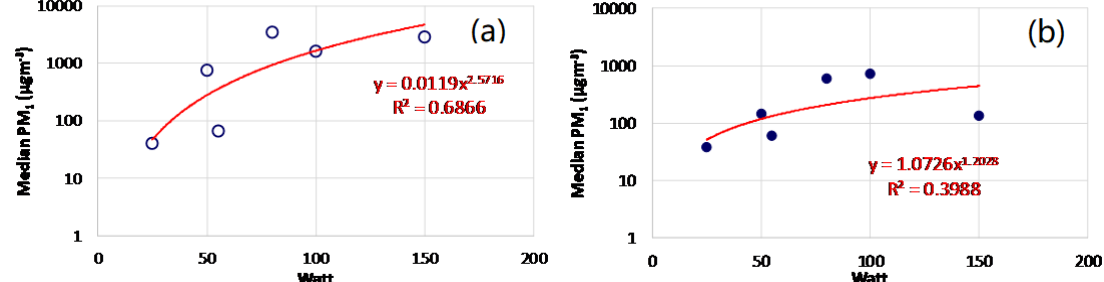
Figure 3. PM 1 concentrations ( µ g m − 3 ) emitted by the fourth generation e-cig as a function of operating power (Watt), both for e-liquid with nicotine ( a ) and e-liquid nicotine-free ( b ).